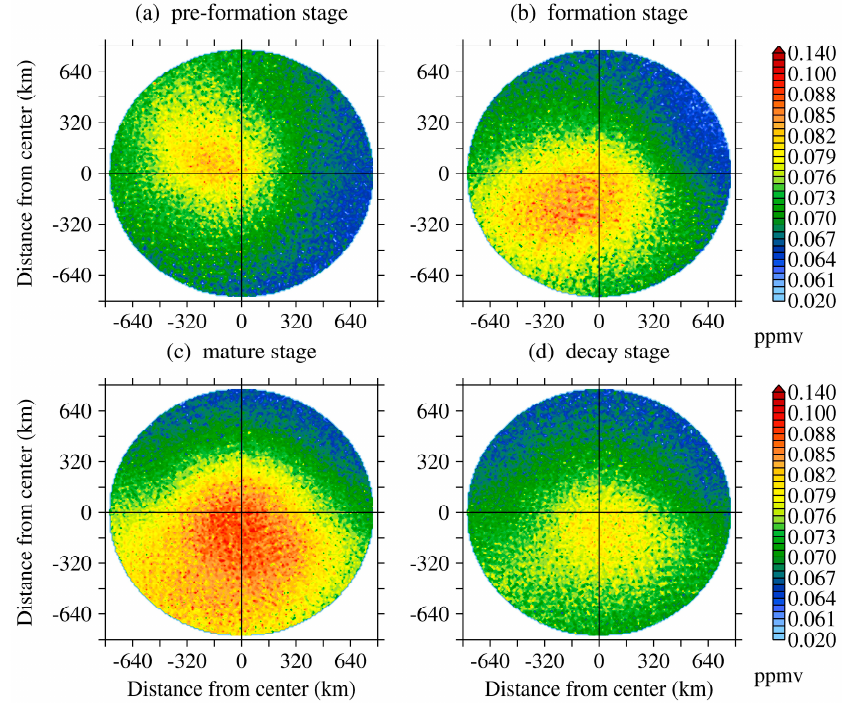
Figure 8. Same as Figure 7, but for the middle troposphere (~500 hPa).